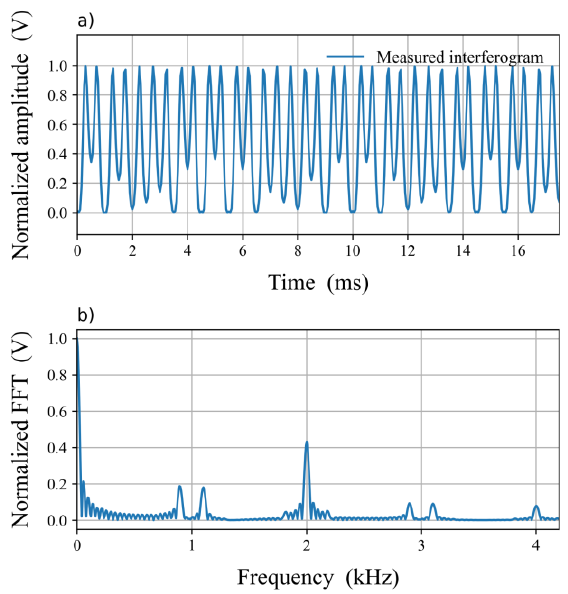
Figure 2. ( a ) Normalized measured interferometric signal, using the optical setup of Figure 1 and ( b ) its spectrum (FFT